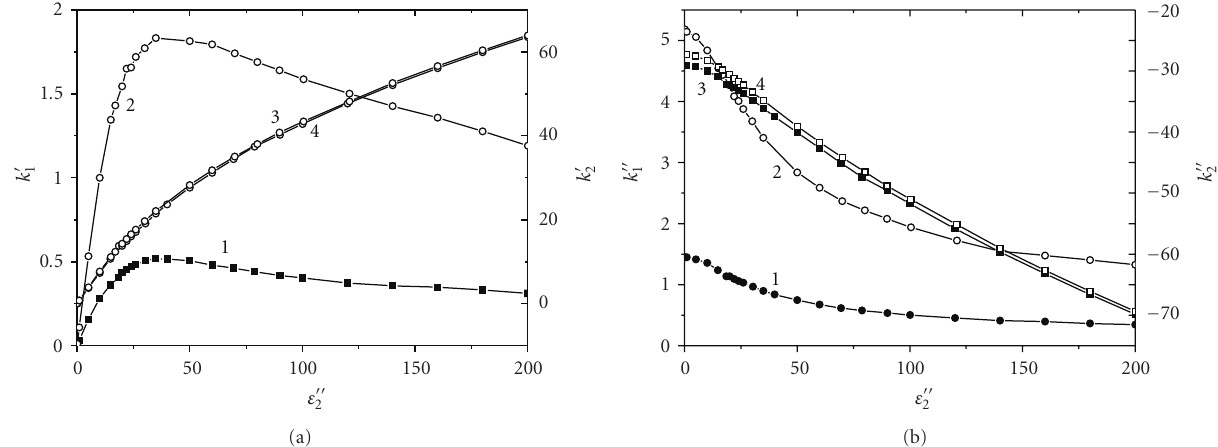
, k (cid:2) (a) and imaginary parts k (cid:2)(cid:2) , k (cid:2)(cid:2) (b) on complex permittivity part ε (cid:2)(cid:2) 2 for the z 1 z 2 z 1 z 2